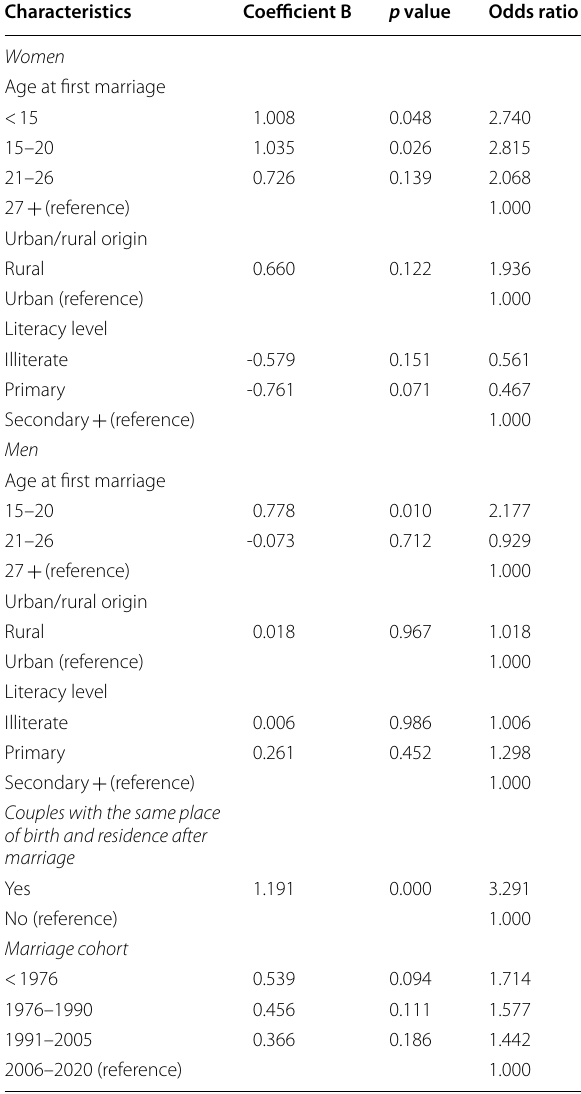
Table 4 Determinants of consanguineous marriage for both genders in the Chaouia population based on Multivariate logistic regression analysis